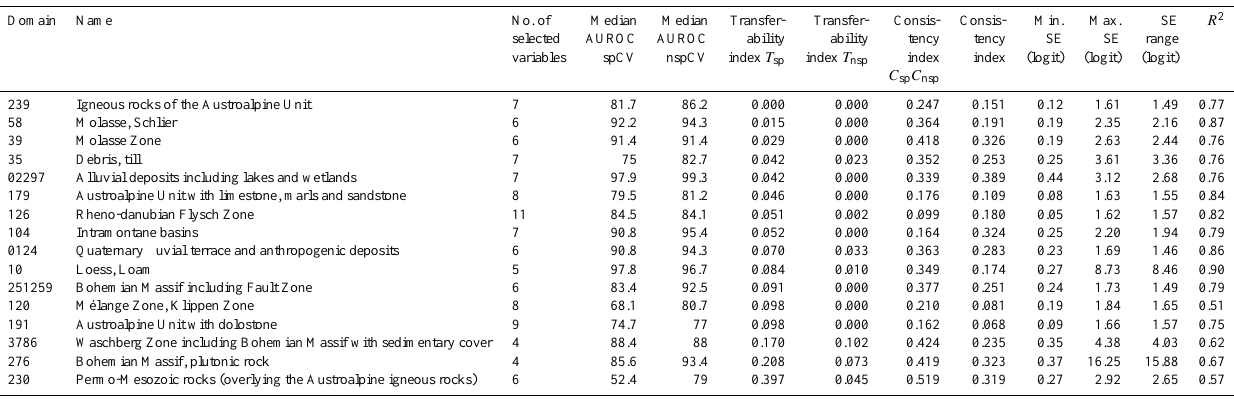
Table 3. Number of selected variables for the models GAM 1 –GAM 16 . Median AUROC values, transferability and thematic consistency of the modelling domains for spatial (spCV) and non-spatial (nspCV) cross-validation. Lower index values T sp ,T nsp and C sp , C nsp indicate strong spatial and non-spatial transferability and thematic consistency, respectively. Minimum (Min.), maximum (Max.) and range of standard error (SE) of the prediction on logit level. R 2 obtained by comparing standard errors estimated by the lookup table to the standard errors calculated by the GAM implementation.